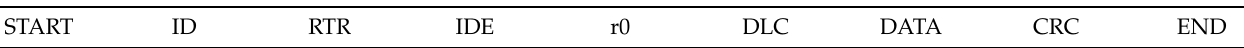
Table 3. CAN data frame.